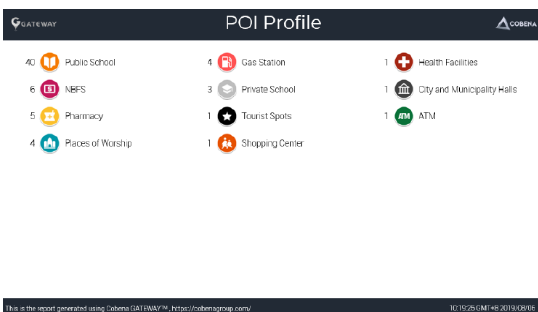
Figure 10. Shows the Demographic Profile screen of the Gateway Area Report.